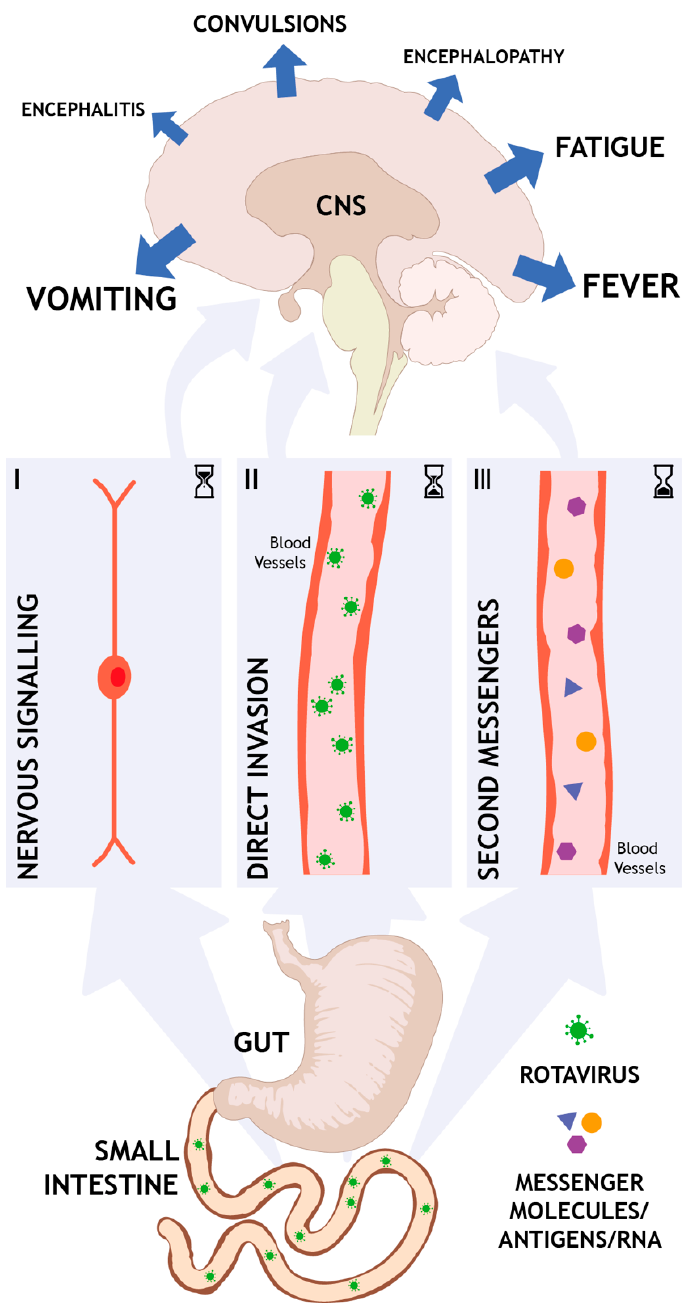
Figure 1. Schematic representation of possible routes by which rotavirus infection can affect the brain to give rise to central nervous system (CNS)-associated symptoms. From very early on, infection-induced released mediators like rotavirus enterotoxin nonstructural protein 4 and serotonin can activate nerves ( I ) that propagate the signal to the brain. In hosts suffering from malnutrition, immunosuppression, or immunodeficiency, virus/-antigen/-RNA may enter the bloodstream and/or the lymphatic system, and together with dysfunction in the blood brain barrier there is a possibility that they directly enter the brain ( II ) to cause less prevalent symptoms like encephalitis or encephalopathy. However, evidence that rotavirus enters the brain is lacking. Finally, infection-induced systemic elevation of rotavirus-antigens or -RNA, toxins, cytokines, and/or other messenger molecules may indirectly ( III ) affect the brain. Routes are not exclusive and could overlap or occur at different timepoint in the same host. Hour glasses represent time lapse post infection. Less common symptoms represented by smaller arrows and text.